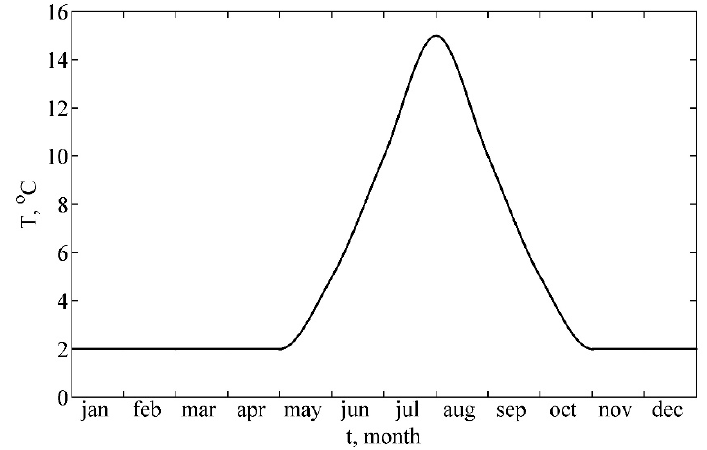
Figure 4. Annual changes in average temperature of water entering the crack. Model Description